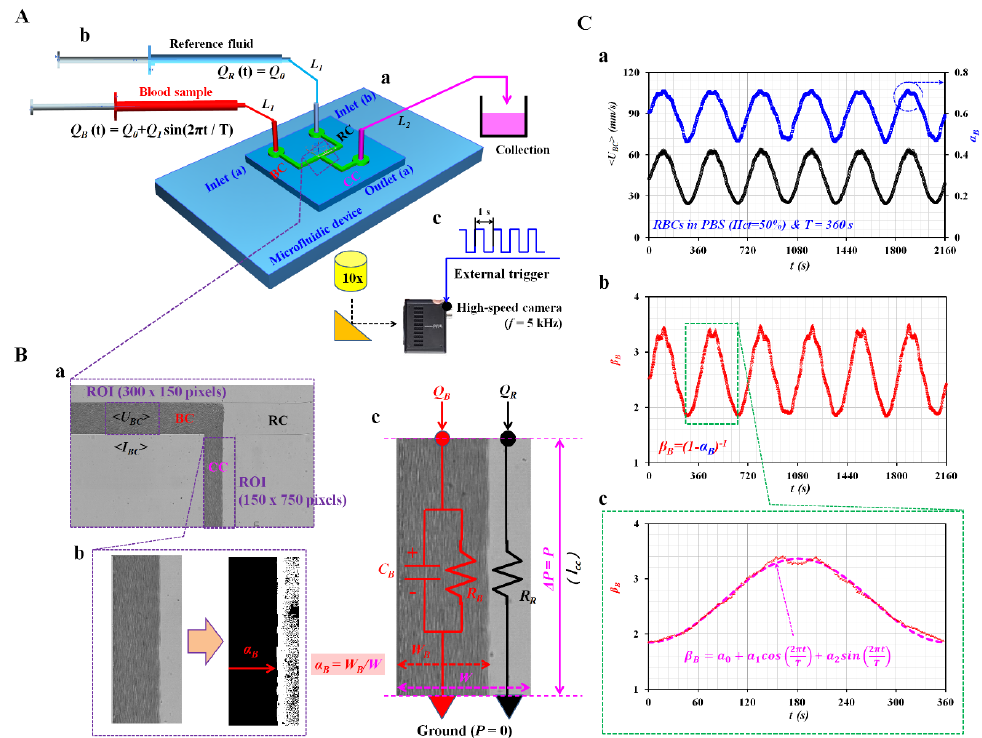
Figure 1. Proposed method for measuring blood viscoelasticity by monitoring the interface of both fluids in coflowing streams under a pulsatile blood flow rate. ( A ) Schematic diagram of the proposed method, including a microfluidic device, two syringe pumps, and an image acquisition system. ( a ) Microfluidic device composed of two inlets (a, b), one outlet (a), two guiding channels (blood sample channel (BC) and reference-fluid channel (RC)), and a coflowing channel (CC). ( b ) Two syringe pumps employed to supply blood sample and reference fluid into the corresponding inlets. ( c ) High- speed camera with a frame rate of 5 kHz employed to capture microscopic images at an interval of 1 s. ( B ) Quantification of interface in coflowing channel and its mathematical model with a discrete fluidic circuit. ( a ) Region of interest (ROI, 150 × 750 pixels) selected in coflowing channel for evaluating interface ( α B ) and ROI (300 × 150 pixels) selected in blood sample channel for evaluating averaged blood velocity ( <U BC > ) or averaged image intensity ( <I BC > ). ( b ) Image conversion from gray- scale image to binary-scale image by using digital image processing. Interface ( α B ) was obtained as α B = W B / W . W B and W represent blood-filled width and channel width, respectively. ( c ) Discrete fluidic